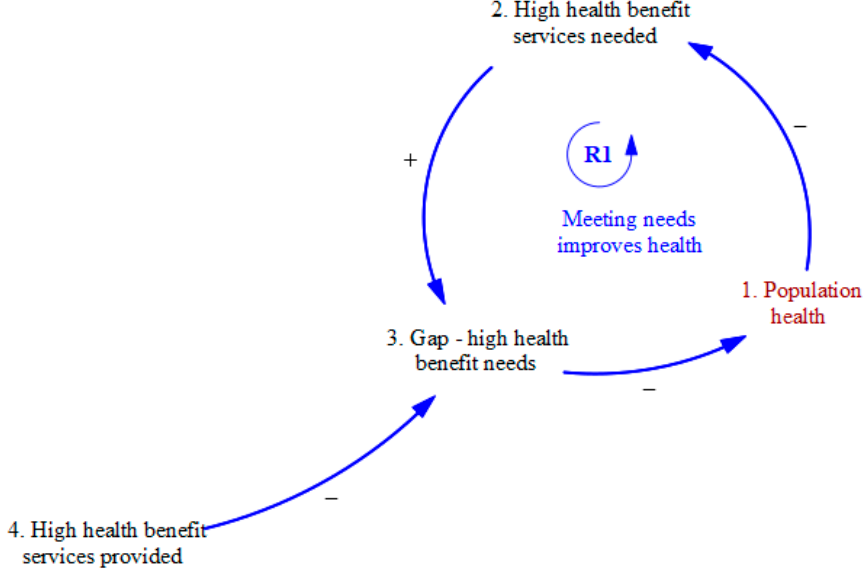
Figure 1. Meeting needs (with High Health Benefit Services) improves population health .